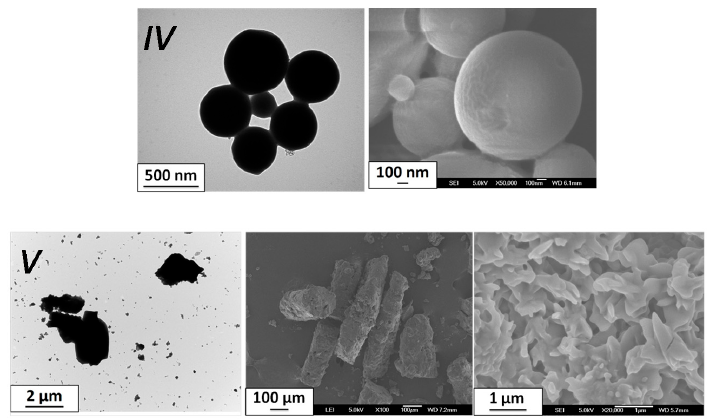
Figure 4. TEM and SEM images of the particles obtained from spray-drying for the selected batches IV ( high ) and V ( low ) for [Fe(NH 2 trz) 3 ](BF 4 ) 2 .